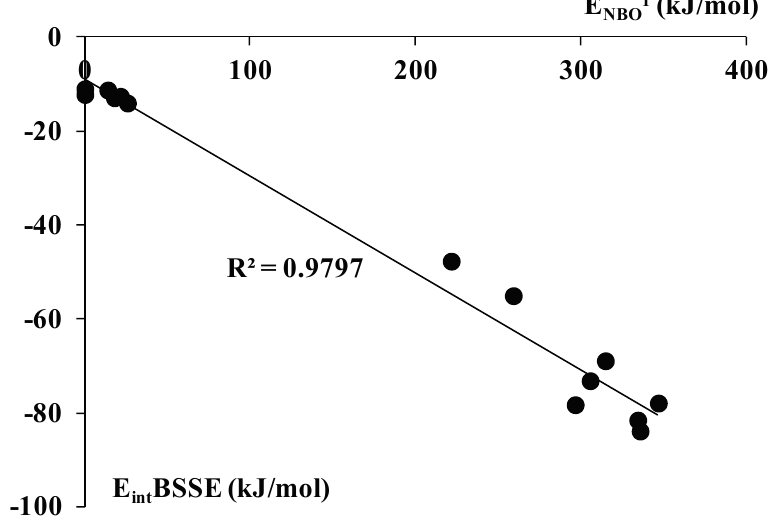
Figure 5. The correlation between the π CC → n Z * orbital–orbital interaction energy (designated as E NBO1 ) and the E int BSSE (this is E int defined in section 3 and next corrected for BSSE); both values in